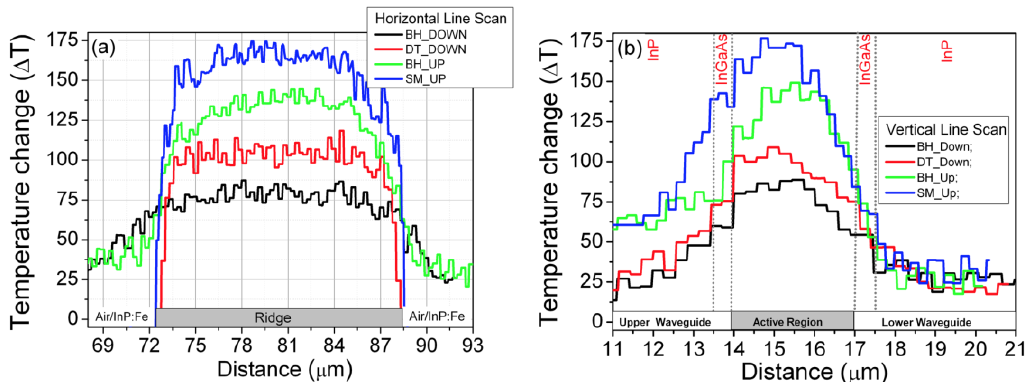
Figure 9. Temperature distribution line scans across the facet taken parallel to the epitaxial layers ( a ) and vertical temperature line scans taken perpendicular to the epitaxial layers ( b ) recorded at the same current density J th = 4.0 kA/cm 2 .